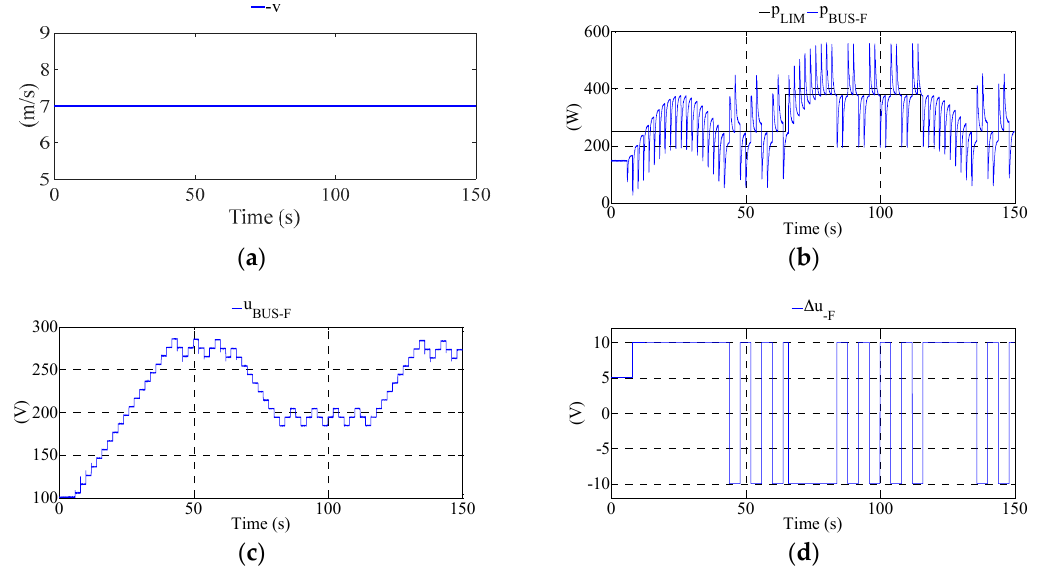
p ; ( c ) evaluations of u ; BUS BUS